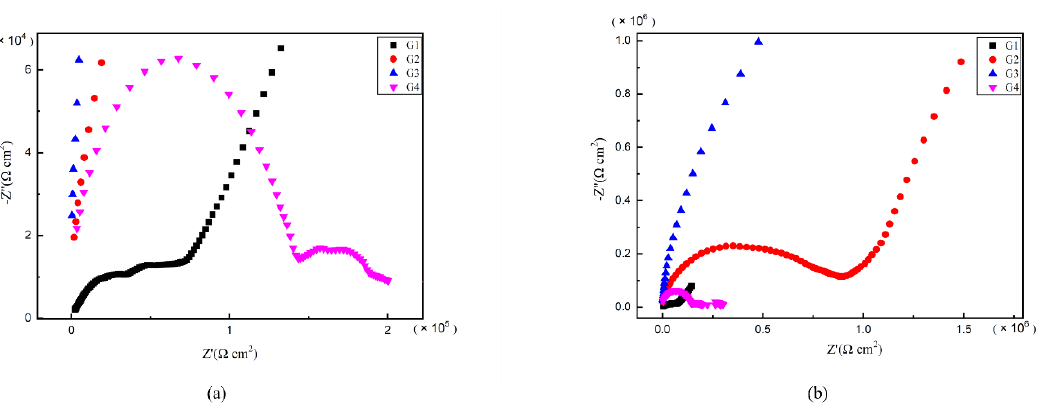
Figure 8. Each EP/CeO 2 -GO coating’s Nyquist pattern for immersion for 16 d: ( a ) Nyquist patterns for 16 d; ( b ) amplification of Nyquist patterns for 16 d.